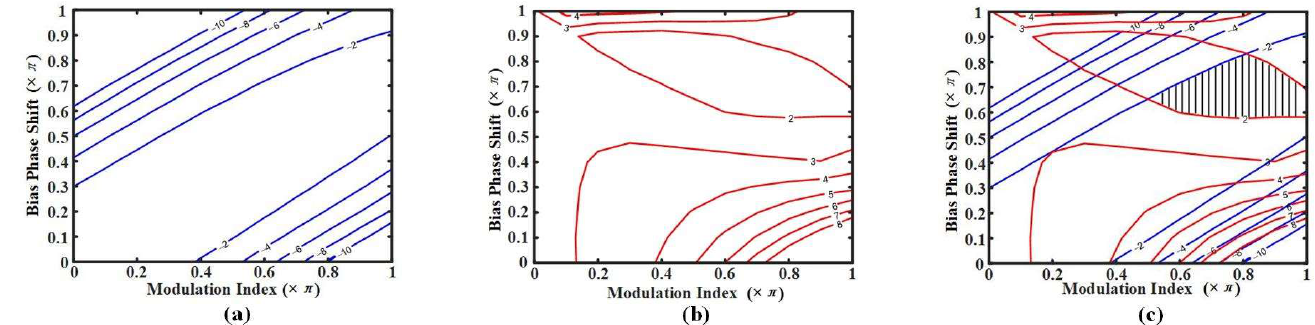
Figure 3. Contour maps showing ( a ) the normalized power in dB of the 5th-order multiplied-frequency component at 40 GHz, ( b ) the power fluctuation over the frequency range from 8 GHz to 40 GHz, under various modulation indices, and the bias phase shifts of the MZM. ( c ) The overlapping contour map of Figure 3a,b.